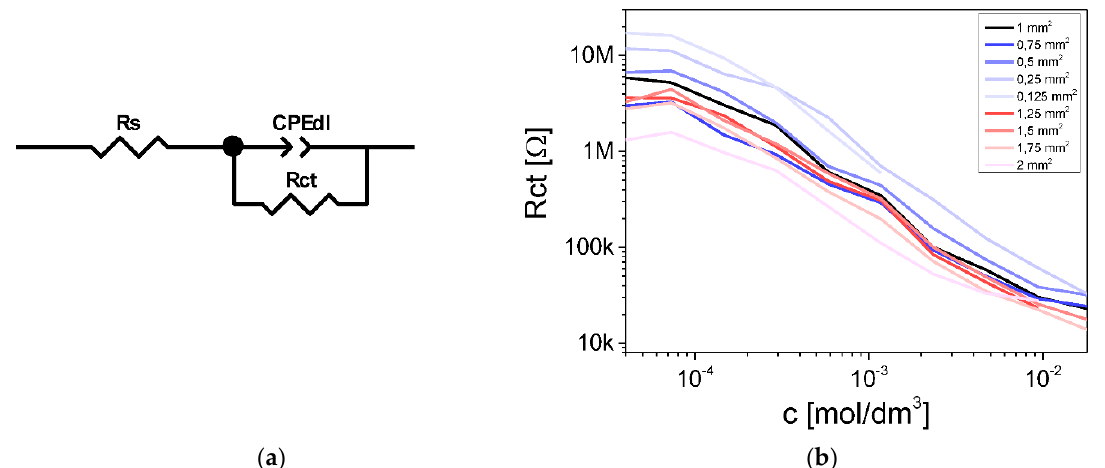
Figure 2. ( a ) Electrical Equivalent Circuit used in experiment, ( b ) Charge transport resistance as a function of the concentration of Fe 2+/3+ for integrated electrochemical cell.